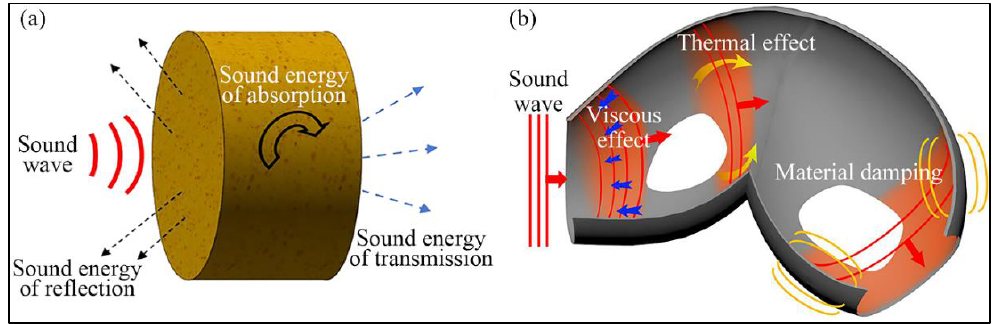
Figure 3. ( a ) Schematic illustration of the sound absorption process for porous materials; ( b ) Process of the sound energy consumption in the porous sound absorption materials. Reprinted with permission from ref. [63]. Copyright 2017 American Institute of Physics.